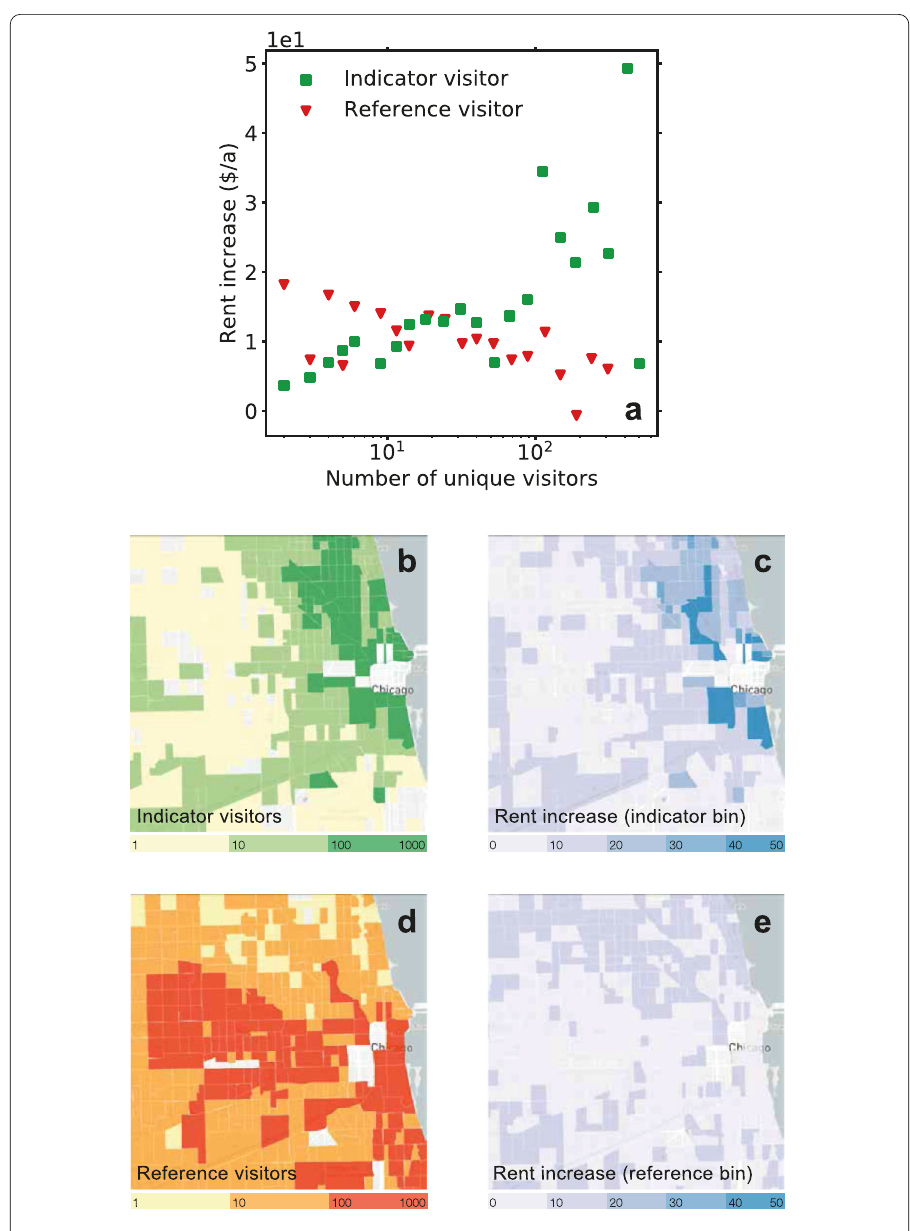
Figure 3 Comparing the predictions of the indicator group and the reference group. ( a ) For each neighborhood bin in Chicago, we compare the number of unique indicator visitors (green) and the number of reference visitors (red) in 2012/2013 with the 2012-2015 change of the census median rent. Neighborhoods with more indicator visitors tend to experience a higher rent increase. ( b )–( c ) Mapping the rent price predictions (a) for the indicator group, and ( d )–( e ) for the reference